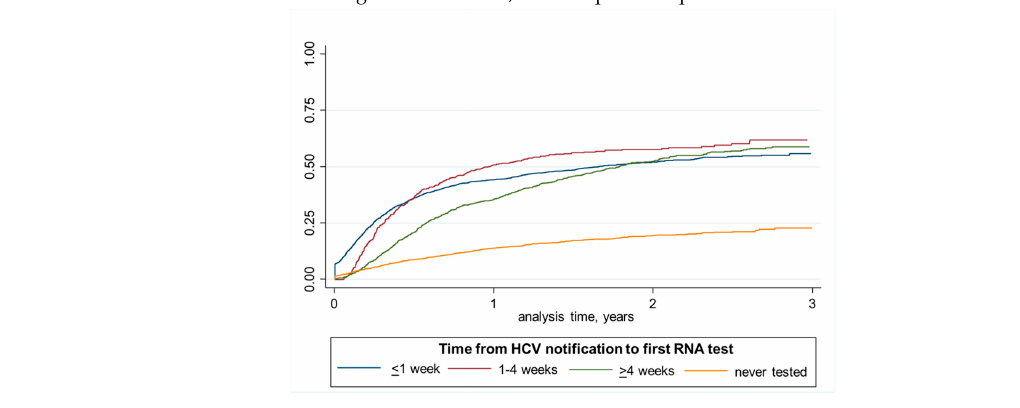
Figure 3. Kaplan–Meier failure curve comparing the proportion of DAA treatment across different times to first RNA testing among people with an HCV notification in NSW